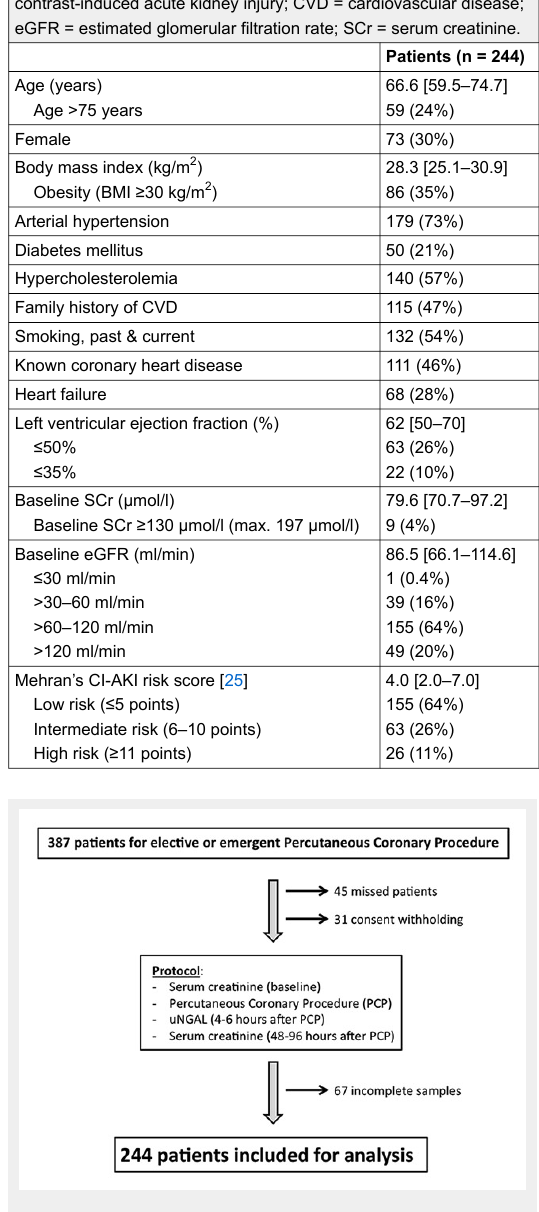
Study flowchart. uNGAL = urinary neutrophil gelatinase-associated